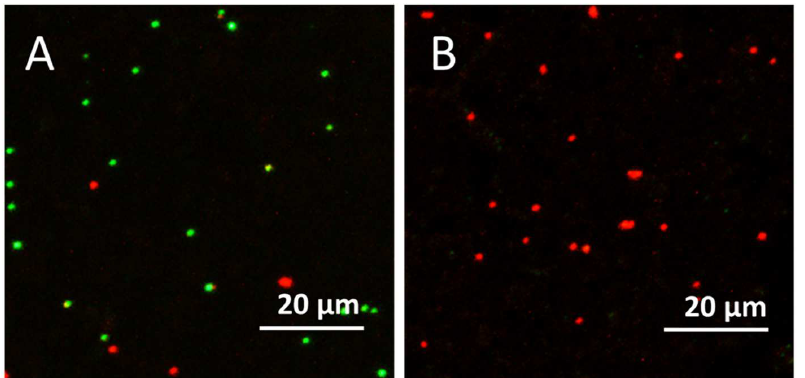
Figure 8. Representative Confocal Laser Scanning Microscopy (CLSM) images of live/dead staining of S. aureus on the coating surfaces of EVA-composite in the dark ( A ) and after the visible-light illumination ( B ) for 30 min. Viable cells—green (Syto9); dead or membrane damaged cells—red (PI). Scale bars represent 20 µm.